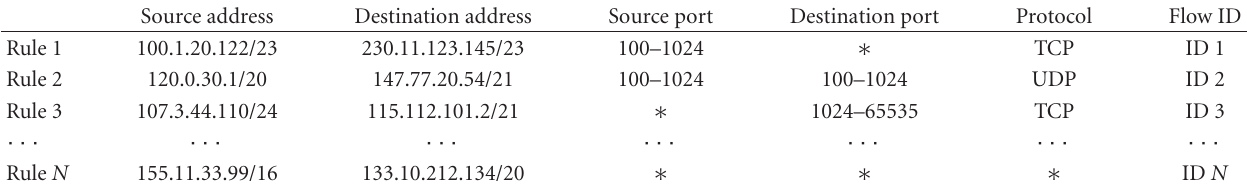
Table 1: Rules table of a 5-tuple